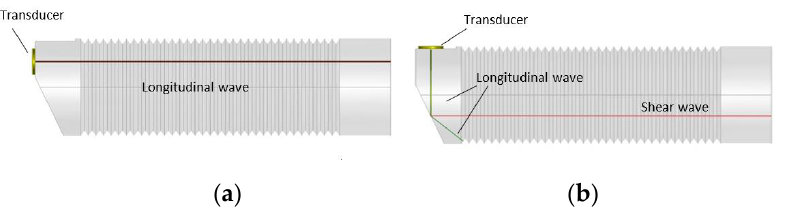
Figure 5. Ultrasonic transducers with threaded buffer rods: ( a ) with longitudinal waves; ( b ) with transformation of longitudinal waves to shear waves.